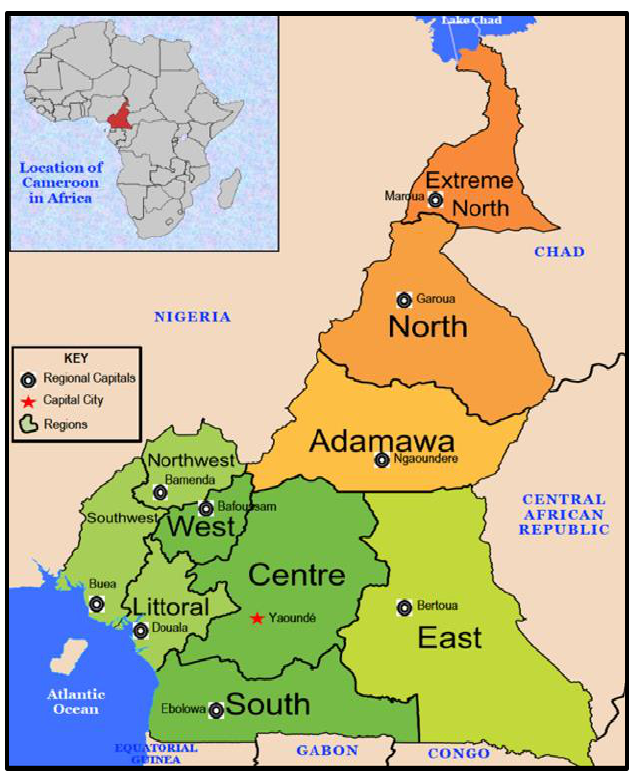
Figure 1. Map of Cameroon showing the 10 administrative regions. Source: Author.